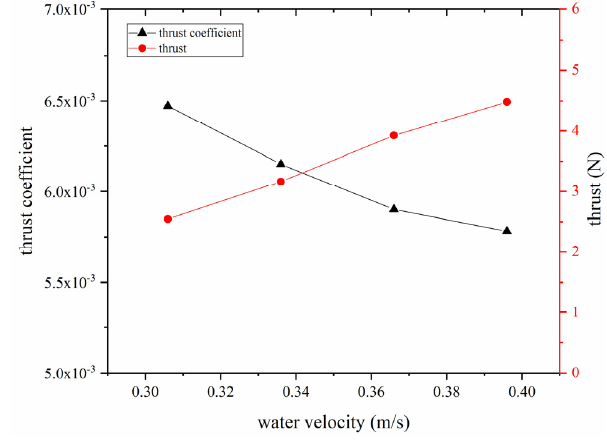
( d ) 𝑣 = 0.396 m/s Figure 17. Pressure distribution on blade upper surface. 5.4.2. Shaft Backward Angle When 𝑣 = 0.366 m/s and 𝜃 = 0 ° , the thrust 𝑇 and thrust coefficient 𝐶 (cid:3021) was calcu- lated by CFD simulation with the shaft backward angle 𝛿 (cid:3046) . Figure 18 show the thrust and thrust coefficient with various shaft backward angles. As can be clearly seen in Figure 18 the thrust force is linearly and positively related to the shaft backward angle. However, the thrust coefficient scarcely varies with the shaft backward angle. Figure 19 shows the force analysis of the blade profile. The increase in the shaft back- ward angle causes the vertical velocity 𝑈 (cid:3017) to rise. The tangential component of water ve- locity in the rotor disc is negligible relative to the blade’s rotational linear velocity, so that 𝑈 (cid:3021) is essentially close to the blade’s rotational linear velocity. Thus, at a fixed rotational speed, the angle of attack 𝛼 increases as the shaft backward angle increases, resulting in an increase in the lift 𝑑𝐿 and drag 𝑑𝐷 . The increase in angle of attack 𝛼 also leads to an increase in the lift-to-drag ratio, so that the increment of the lift component 𝑑𝐿 is greater than the increment of the drag component 𝑑𝐷 in the horizontal direction, which in turn generates a driving force that increases the rotor speed. An increase in rotor speed leads